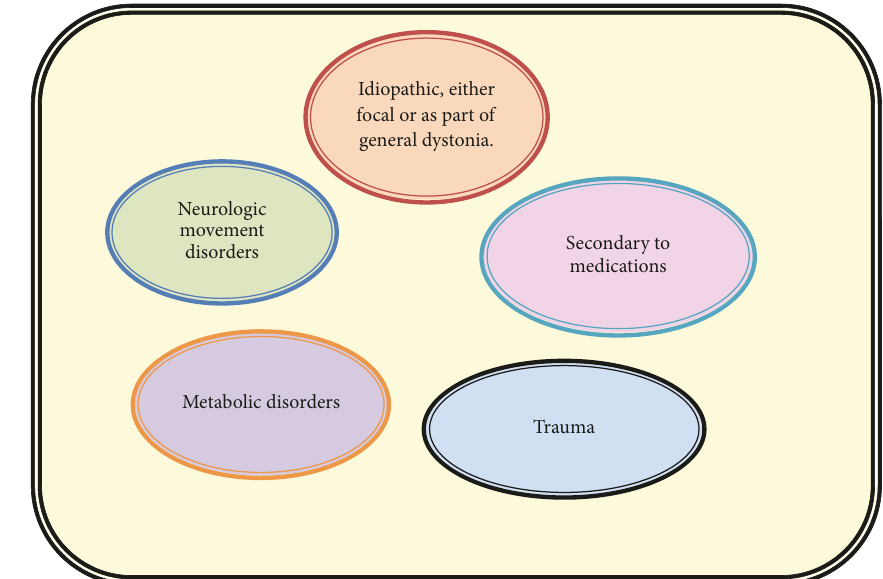
Figure 7: Etiology of Oromandibular Dystonia.